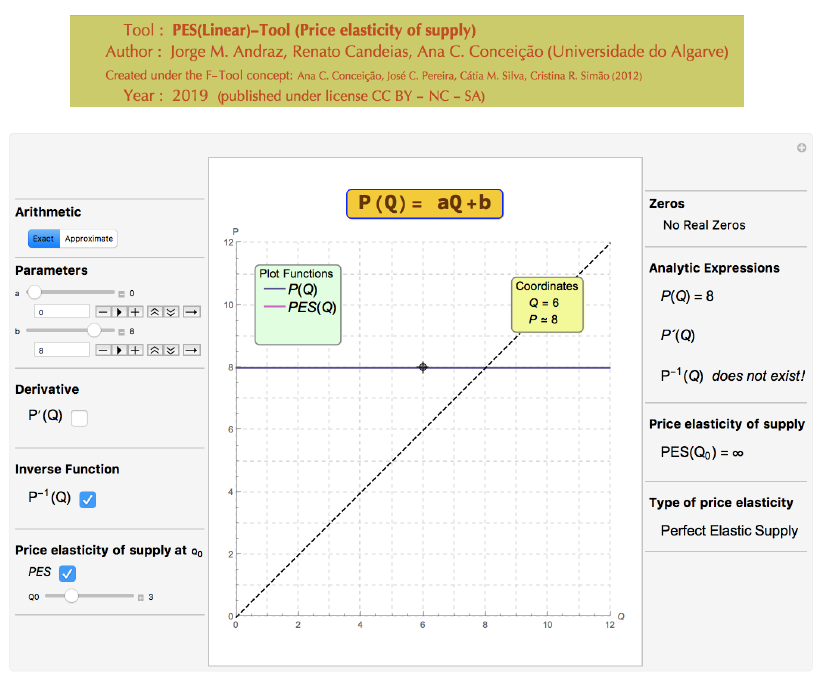
(cid:16) (cid:17) − b ,0 . a